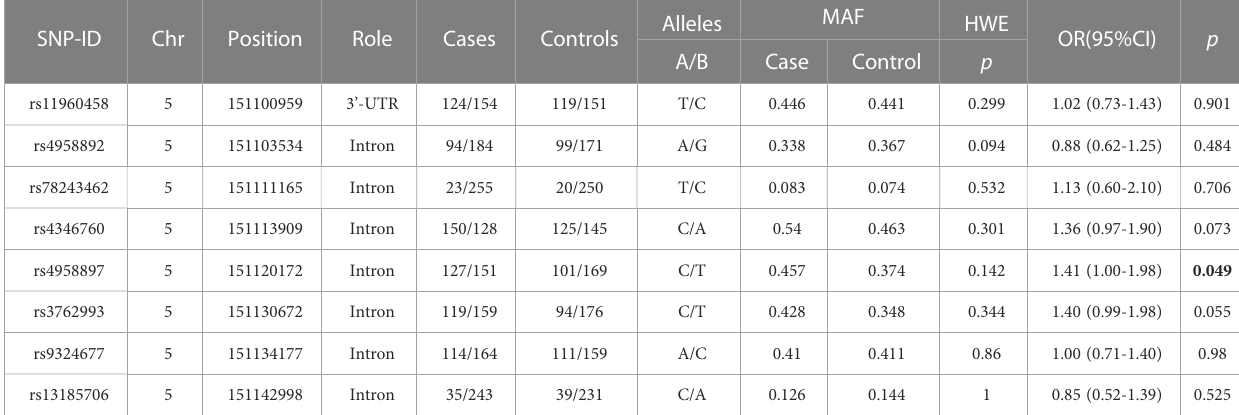
TABLE 2 Primary information of selected SNPs in ANXA6 .